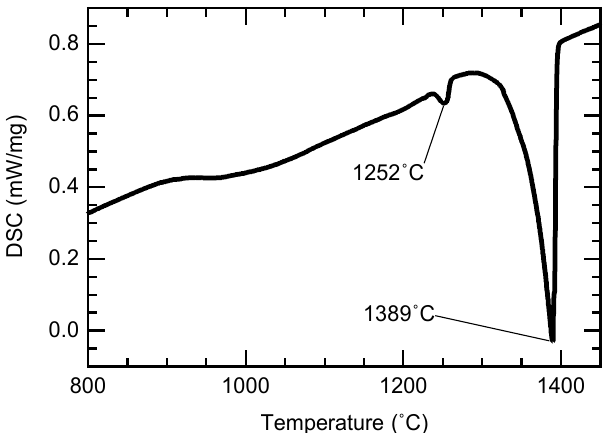
Figure 10. DSC thermogram of as-cast Stellite-21 with the two major endothermic peaks labelled.